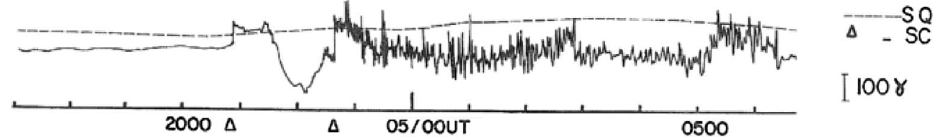
Fig. A.1. Manila Observatory magnetic X -component variations from August 4, 1972 at 17 UT to August 5 at 7 UT (Salcedo, 1973x).